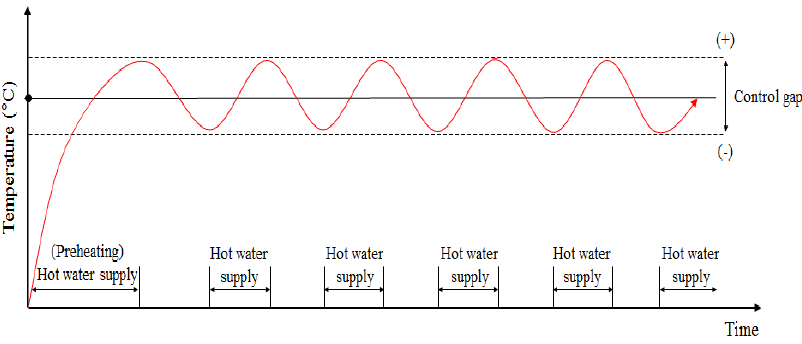
Figure 2. Hot water supply over time for a floor heating system without a PCM.